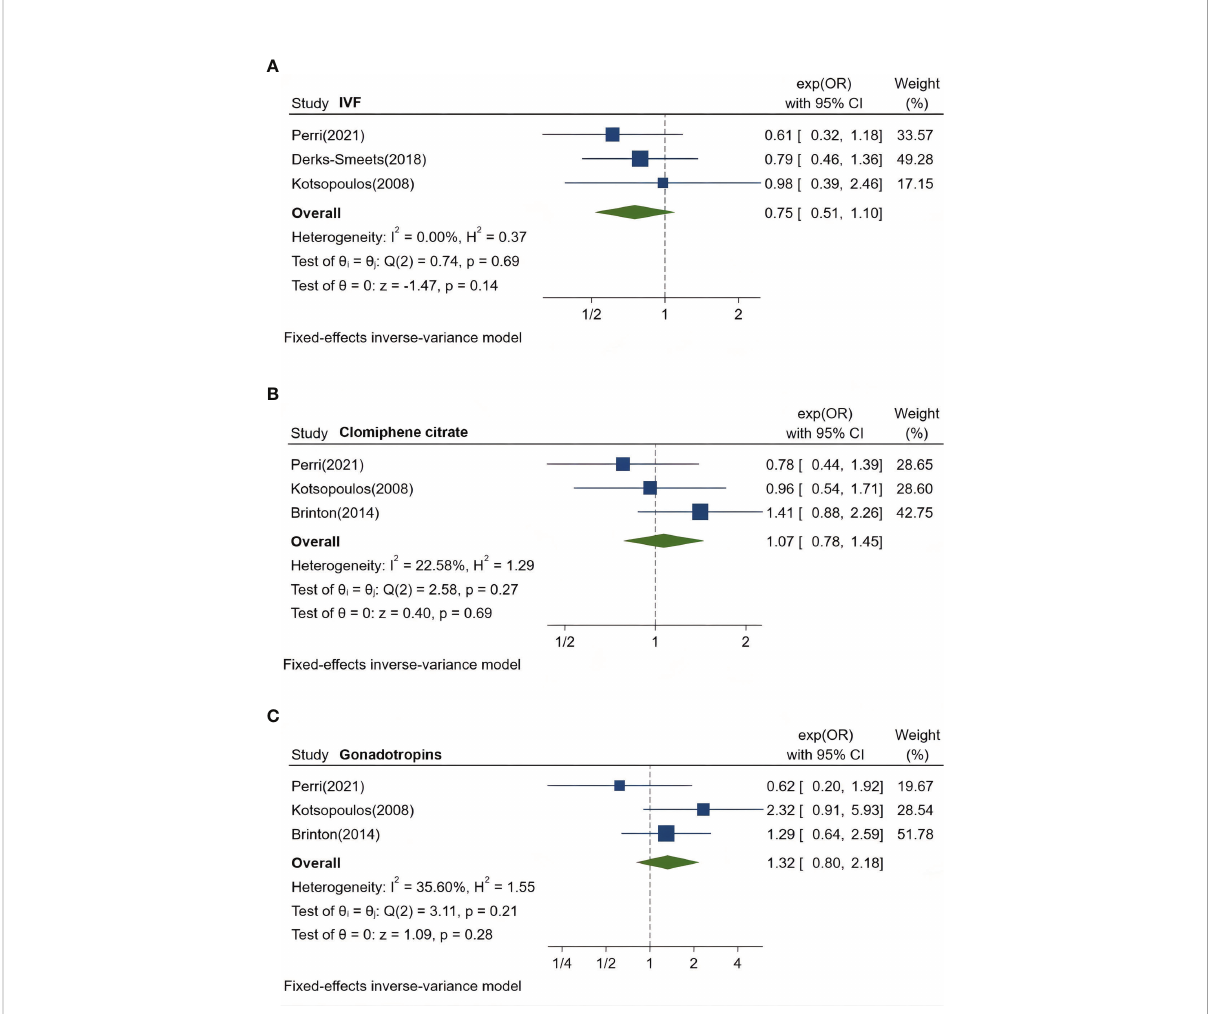
FIGURE 4 Forest plots demonstrating the comparison of breast cancer risk in genetically susceptible women who were treated with IVF, CC, or gonadotropins. (A) , comparison of breast cancer risk in genetically susceptible women treated by IVF or not. (B) , comparison of breast cancer risk in genetically susceptible women treated by CC or not. (C) , comparison of breast cancer risk in genetically susceptible women treated with gonadotropins or not. OR, odds ratio; CC, clomiphene citrate; in vitro fertilization,